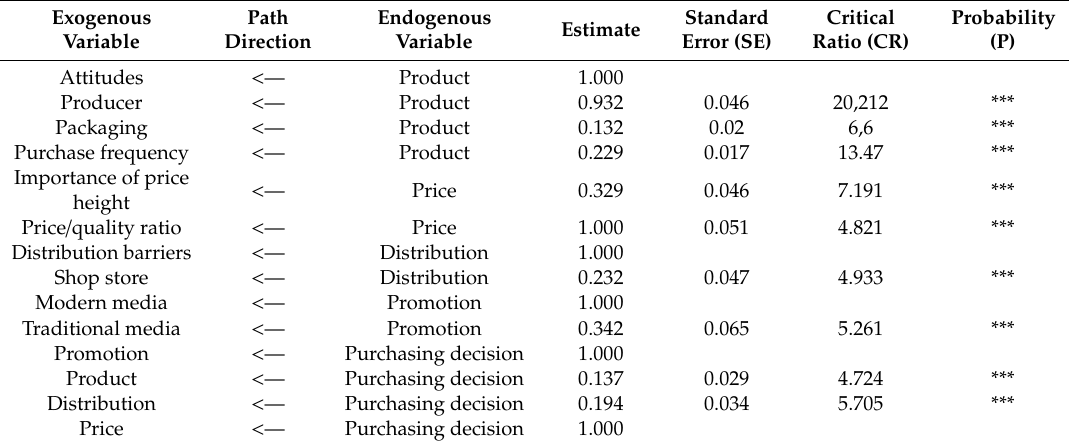
Table 3. Estimation results of the structural equation model